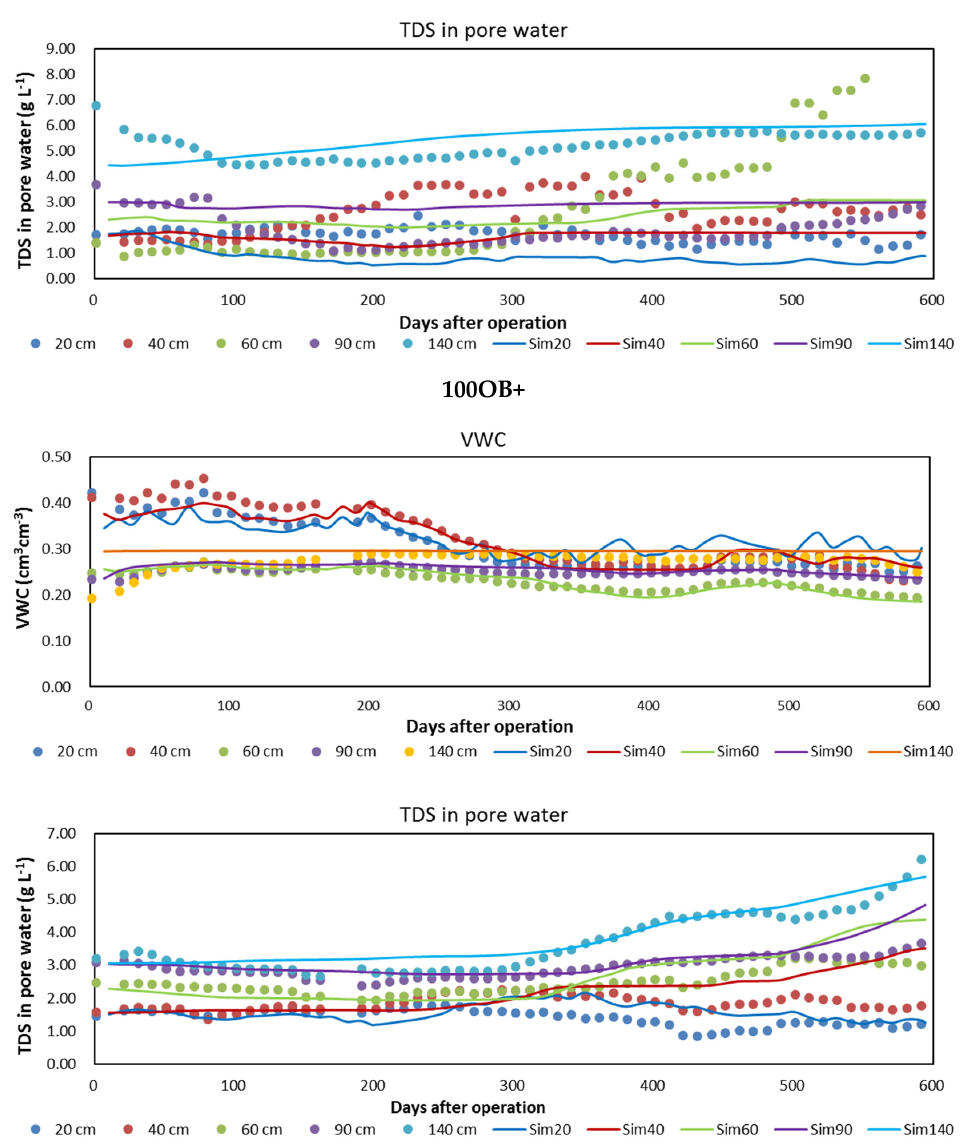
Figure 9. Comparison of the experimental soil moisture and salt concentration with the simulated data using parameters in Table 2 (NC + treatment) ( • average data of the treatment recorded by GS3 probes, —simulated data from HYDRUS-1D). Table 5. Comparison of simulated and experimental soil moisture content and TDS in the soil profile. Soil Property